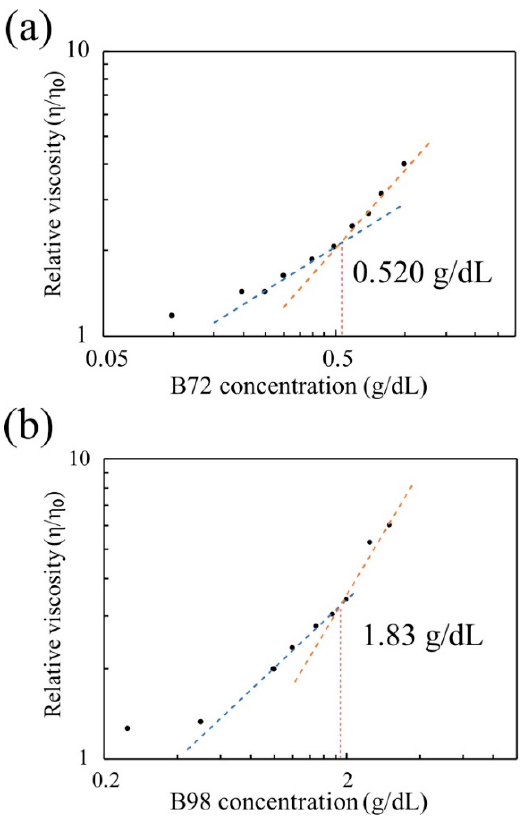
Figure 4. ( a ) Relative viscosity vs. PVB concentration in benzyl alcohol for high-molecular-weight PVB-B72. ( b ) Relative viscosity vs. PVB concentration in benzyl alcohol for low-molecular-weight PVB-B98.